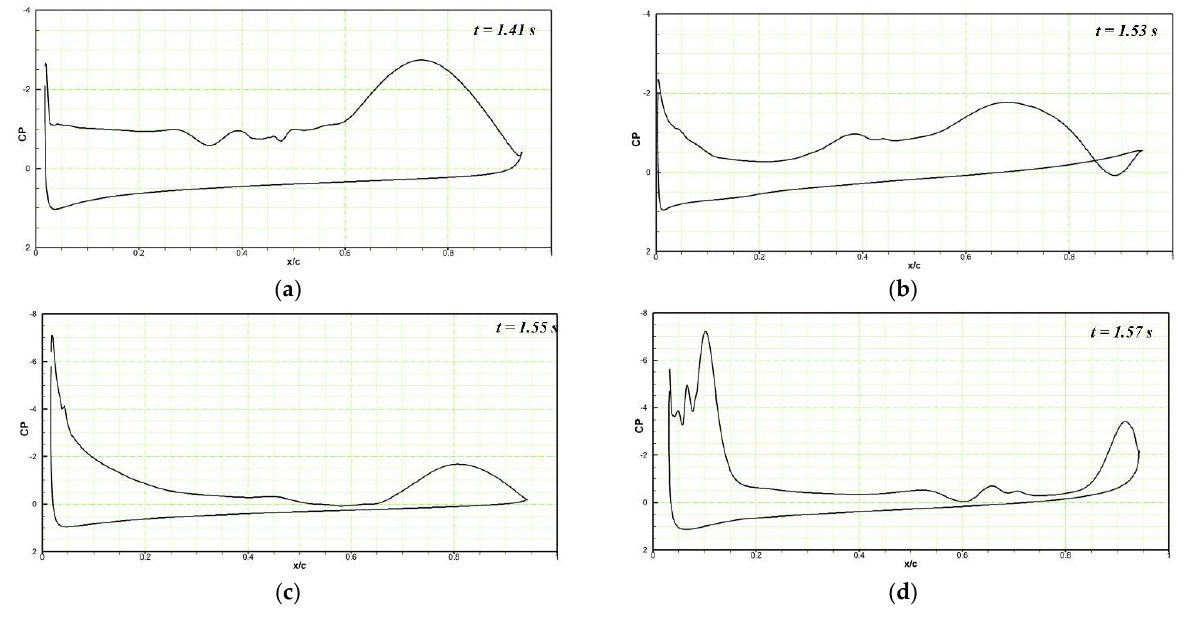
Figure 21. Pressure coefficients variations along the chord comparison of the reference airfoil with the DMLE airfoil at the angle of attack of 22 at the deflection frequency of 10 Hz for ( a ) time step of 1.41 s, ( b ) time step of 1.53 s, ( c ) time step of 1.55 s, ( d ) time step of 1.57 s. These figures reveal the pressure coefficients at different morphing leading edge deflections and also the deflection is faster at higher frequencies.